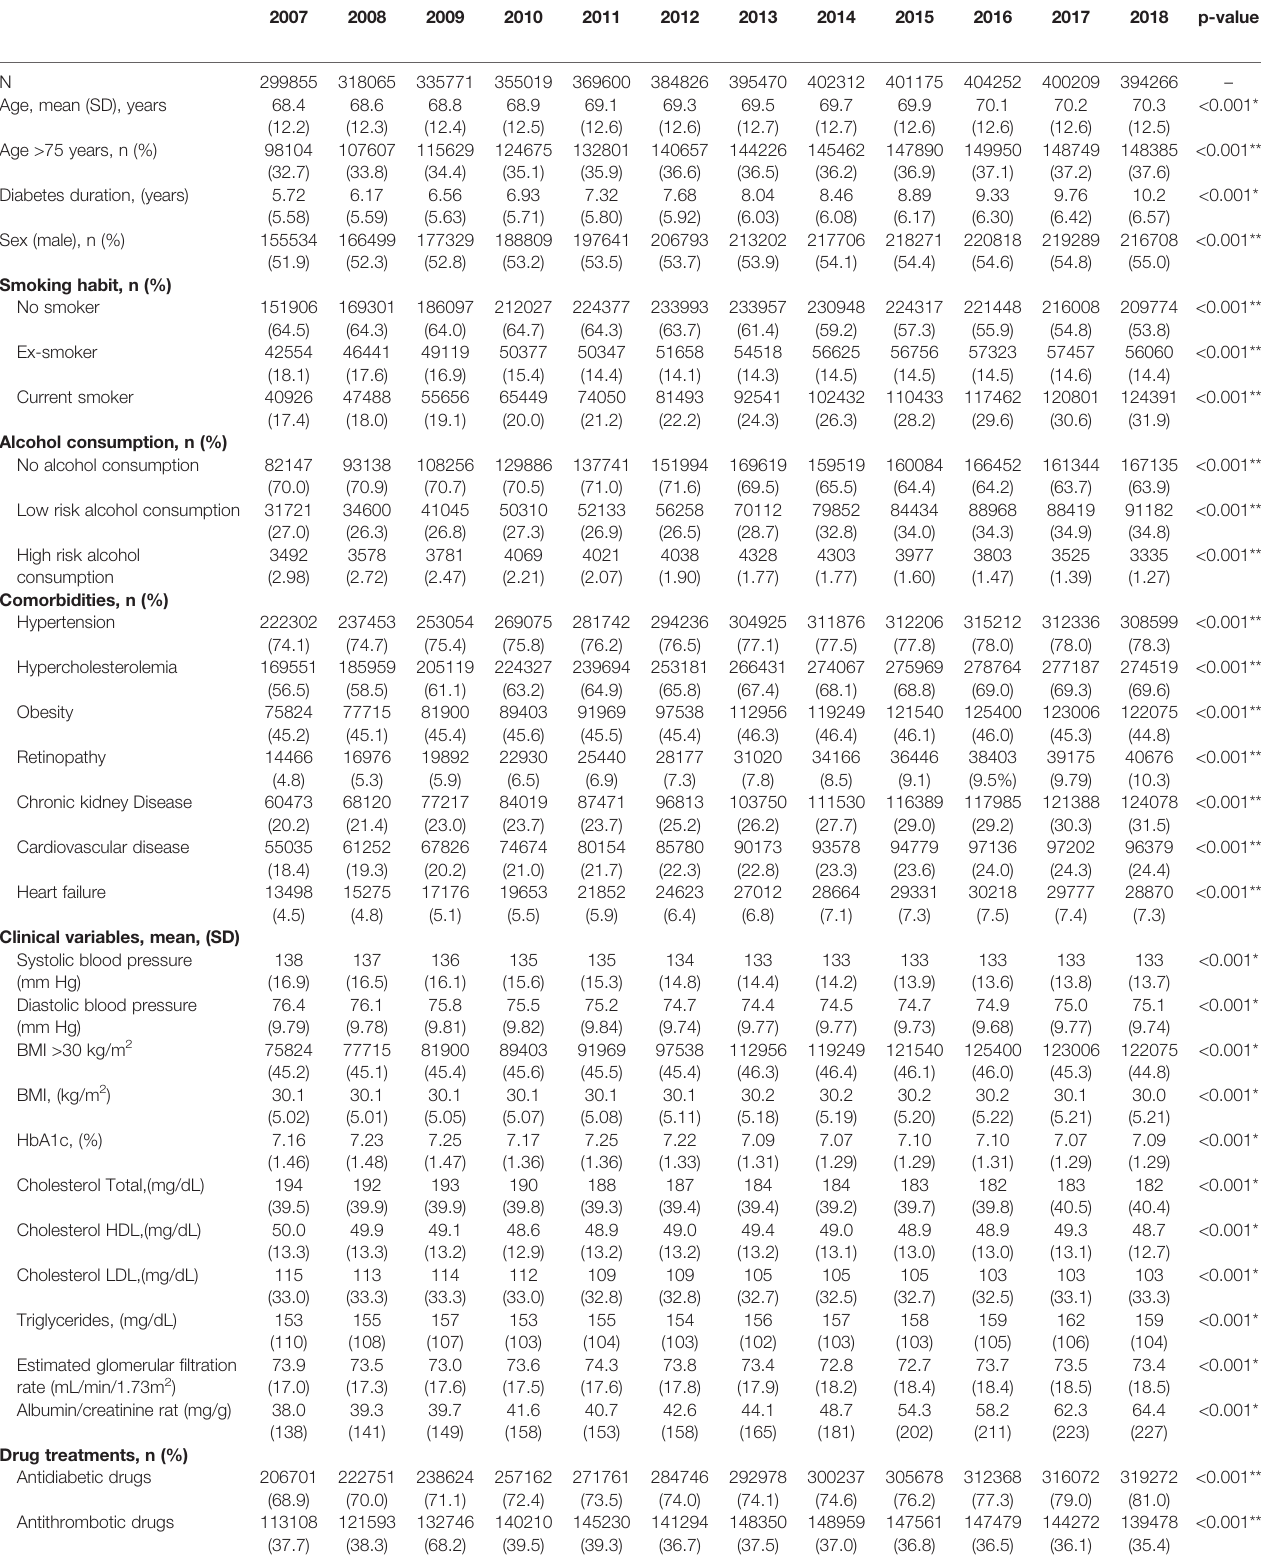
TABLE 1 | Characteristics of the subjects during the study